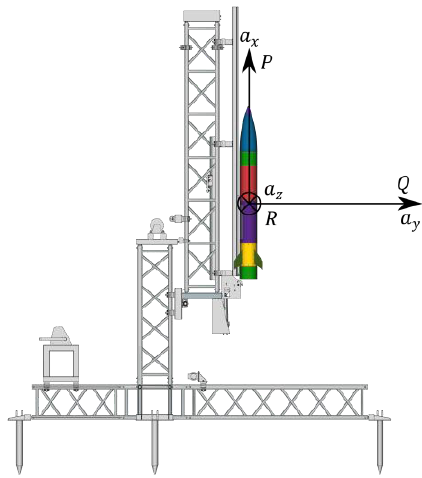
Figure 22. Sensor axis convention (projectile ready to launch).